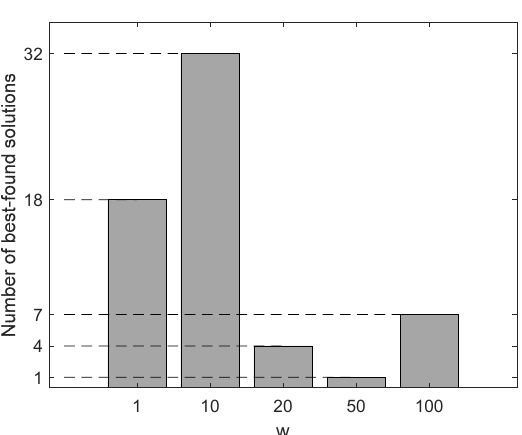
Table 4. Experimental setup parameters.